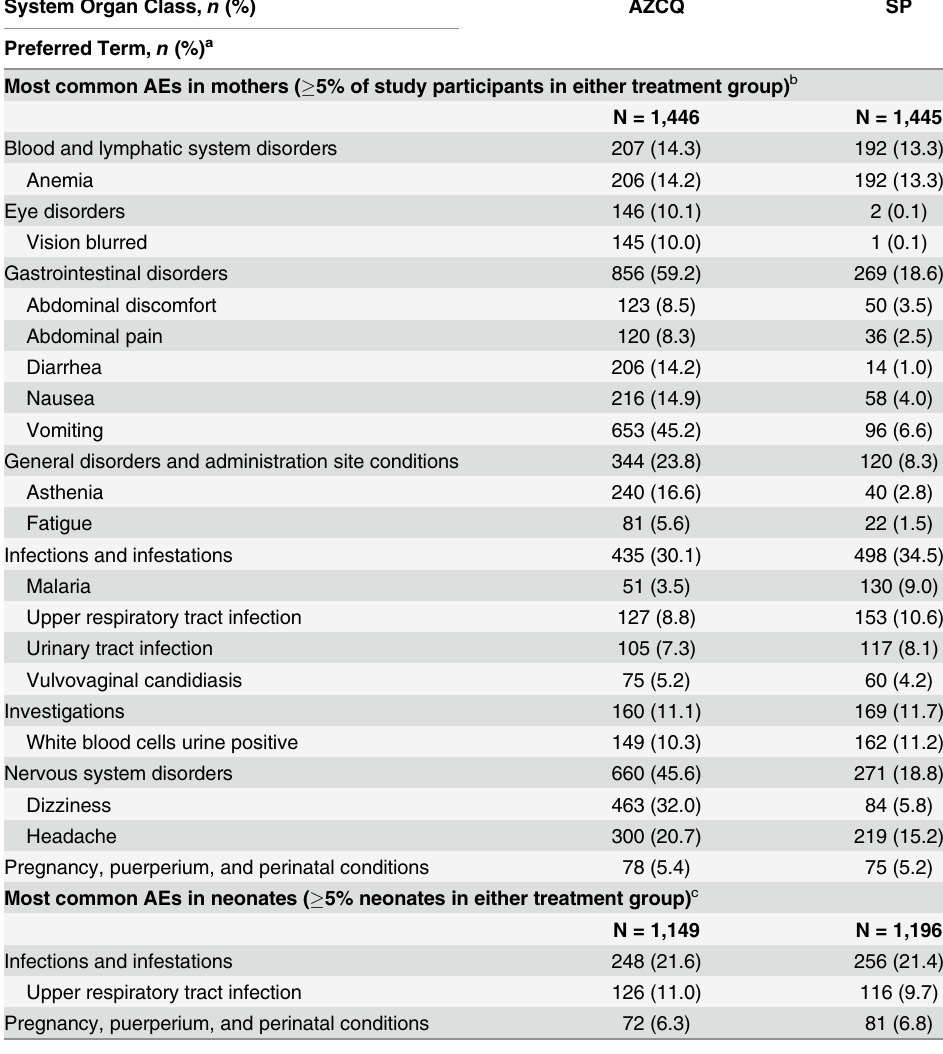
Table 6. The most common all-causality adverse events in the safety population. System Organ Class, n (%) AZCQ SP Preferred Term, n (%) a Most common AEs in mothers ( (cid:3) 5% of study participants in either treatment group)